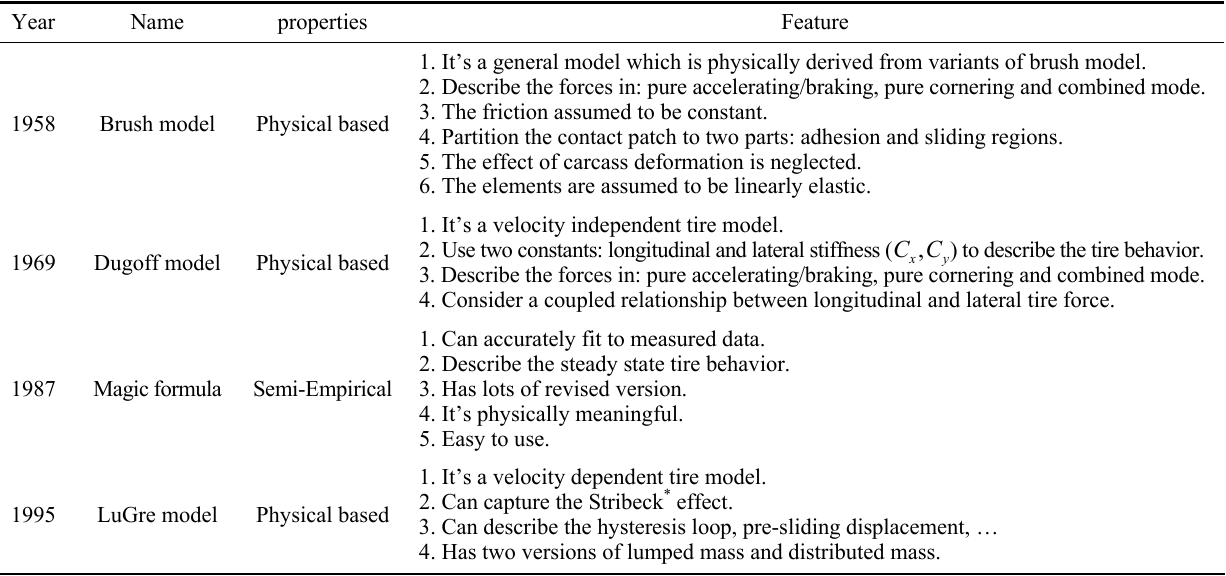
Table 7 Specifications of discussed tire